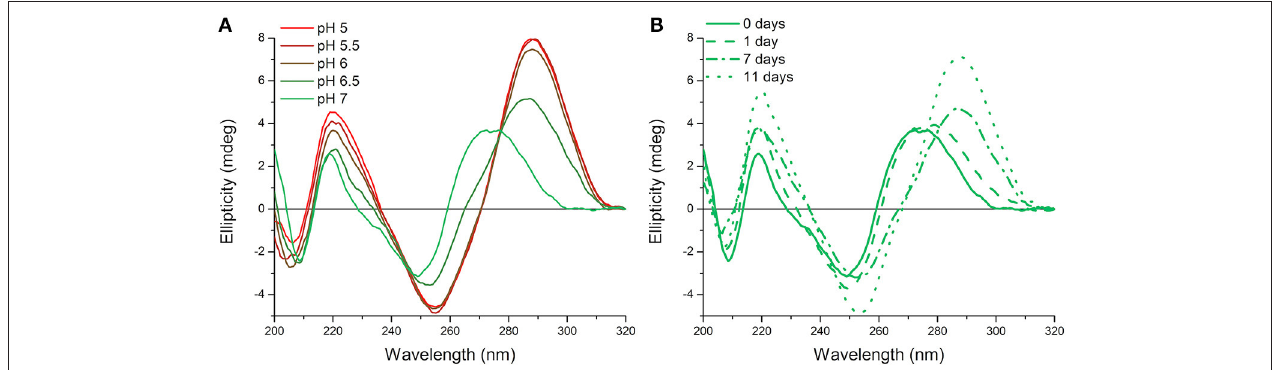
FIGURE 1 | CD spectra of 10 µ M hTeloC in 10mM sodium cacodylate buffer at room temperature. (A) Spectra of samples at different pH values measured without storage at low temperature. (B) Spectra of samples at pH 7.0 measured after storage at 4 ◦ C for the indicated time.